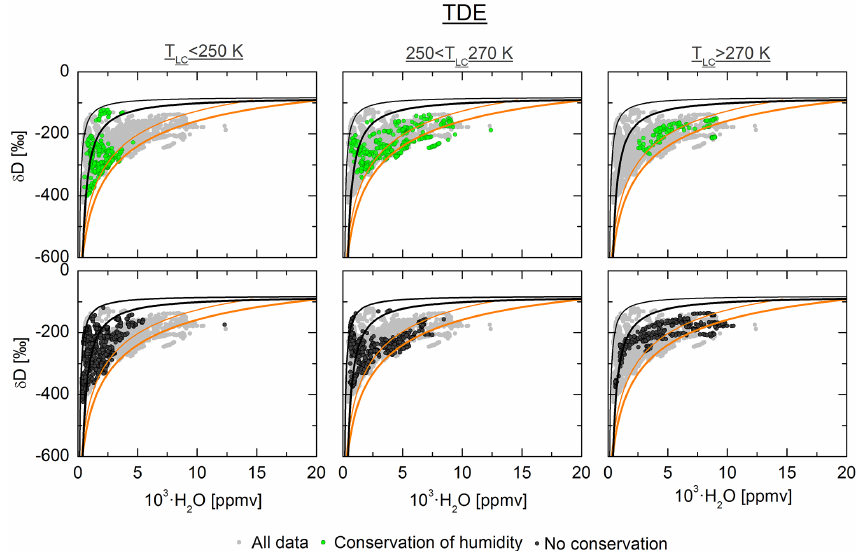
Figure 9. Same as Fig. 8 for the data collected at TDE